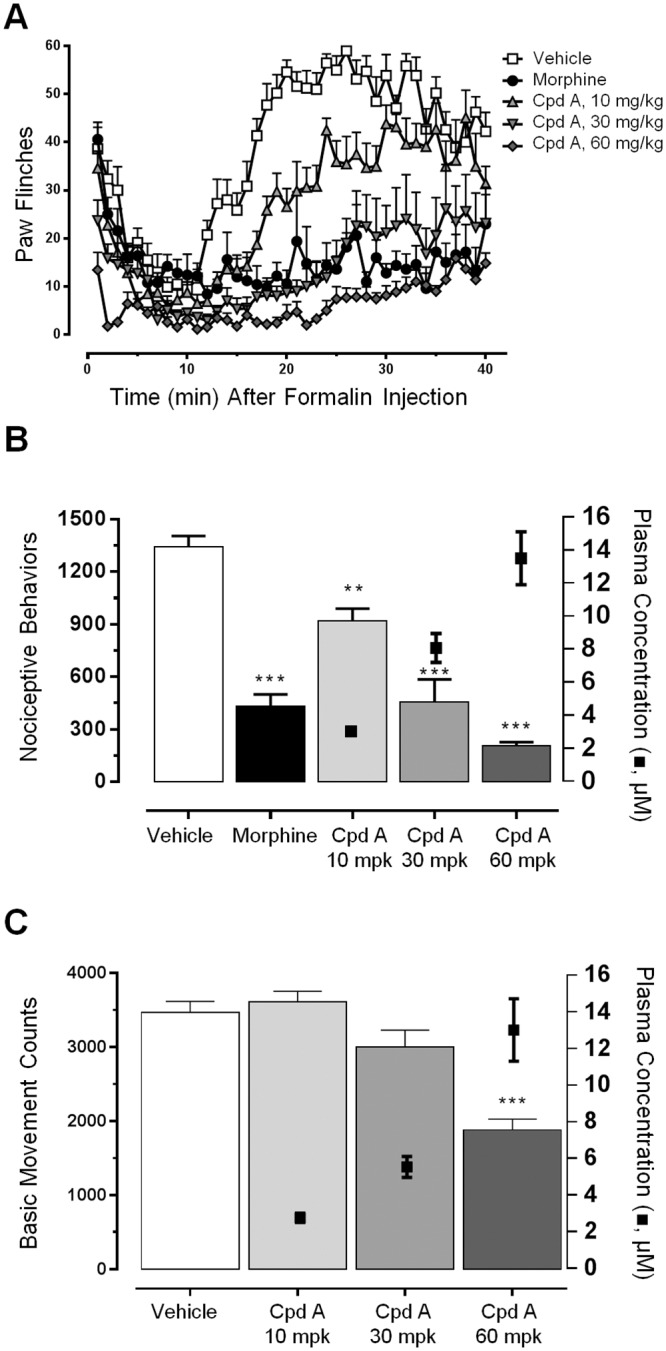
Testing of representative aminotriazine compound A in the formalin model of pain.
A, Timecourse of flinching binned every minute for each of five cohorts: vehicle, positive control morphine (2 mg/kg), and 10 mg/kg, 30 mg/kg, and 60 mg/kg compound A. All cohorts were n = 8 animals, except morphine was n = 5. B, Total flinches in phase 2 (10 minutes to 40 minutes) (bars and left y-axis) and terminal plasma concentrations of compound A (symbols and right y-axis). Total reduction in phase 2 flinching as percent of vehicle: morphine 68%, 10 mg/kg compound A 32%, 30 mg/kg compound A 66%, 60 mg/kg compound A 85%. Terminal plasma and brain concentrations of compound A: for the 10 mg/kg dose plasma 3.02 uM ± 0.21 μM and brain 0.28 μM ± 0.029 μM; for the 30 mg/kg dose plasma 8.07 μM ± 0.65 μM and brain 0.88 μM ± 0.14 μM; for the 60 mg/kg dose plasma 13.5 μM ± 1.60 μM and brain 1.54 μM ± 0.10 μM (for each dose cohort mean ± SEM, plasma n = 8, brain n = 4). C, Effects of compound A on spontaneous locomotor behaviors. Graph shows basic movement counts (bars and left y-axis) and terminal plasma concentrations (symbols and right y-axis) following indicated doses of compound A. Total percent reduction and the corresponding terminal plasma concentrations: for the 10 mg/kg dose -4.2% and 2.75 μM ± 0.26 μM; for the 30 mg/kg dose 14% and 5.53 μM ± 0.57 μM; for the 60 mg/kg dose 46% and 13.0 μM ± 1.7 μM (brains were not analyzed) (for each dose cohort mean ± SEM, n = 8). **p < 0.01, ***p < 0.001.